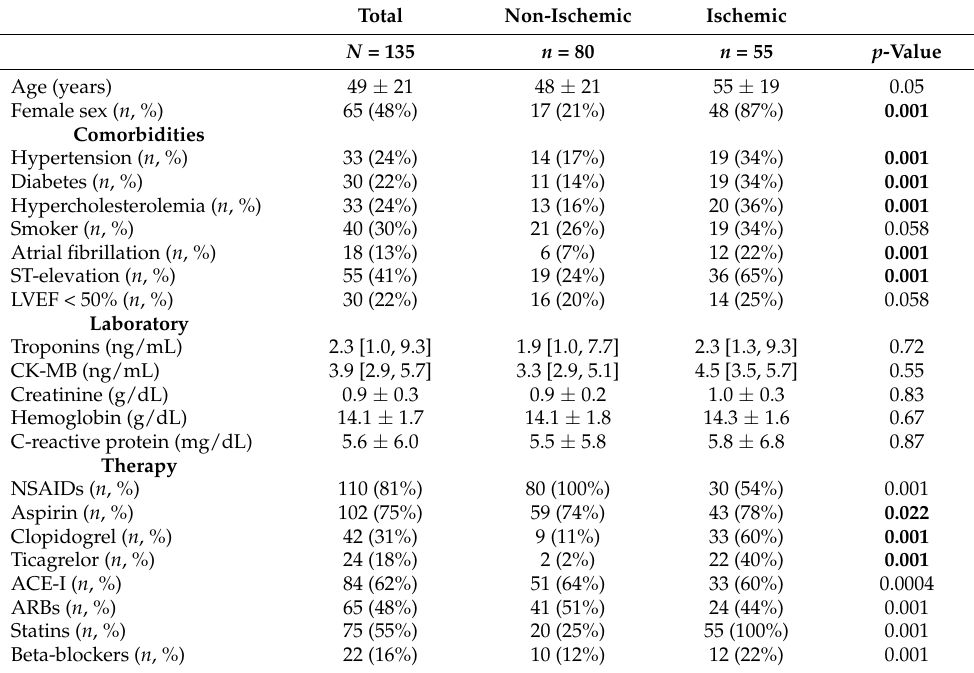
Table 1. General characteristics according to ischemic and non-ischemic CMR patterns. Total Non-Ischemic Ischemic N =